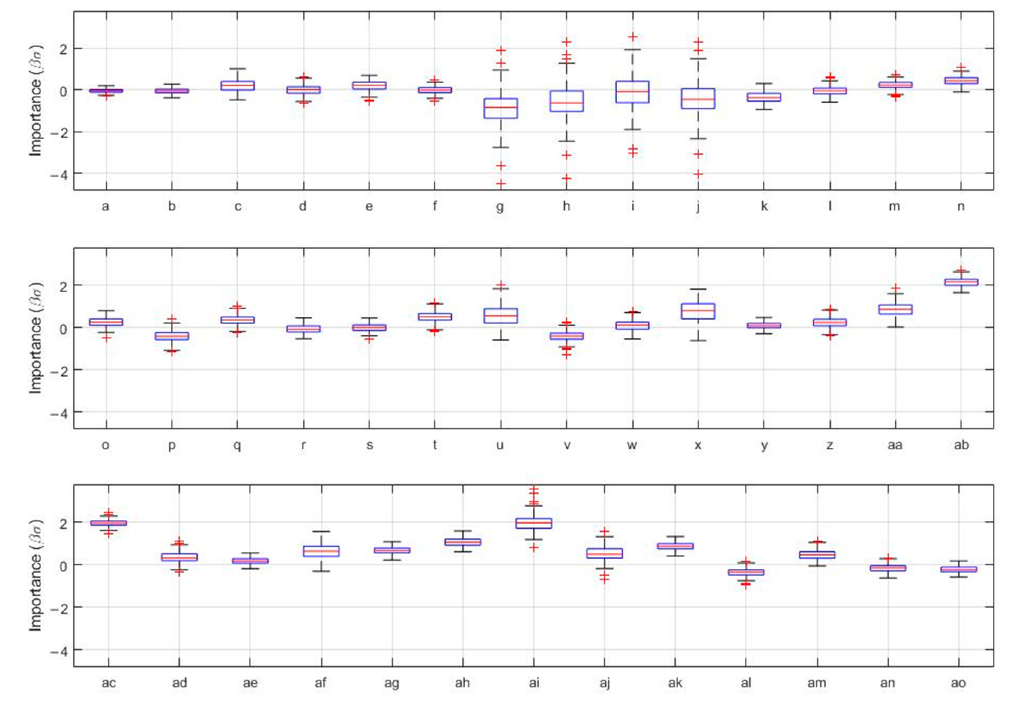
Figure 2. Machine learning models of vaccine hesitancy; boxplots of out-of-sample importance of factors from a single imputation and 200 repetitions of bootstrap resampling for logistic regression models, with the outcome of significant or some hesitancy vs. no hesitancy. a Age; b sex (male); c role (family member); d role (health care professional), e role (patient); f part of a vulnerable population (yes); g highest level of education (bachelor’s degree or above); h highest level of education (high school graduate); i highest level of education (some high school); j highest level of education (technical/vocational training); k employment (retired), l employment (yes); m living with (healthy adults); n living with (high risk people); o living with (susceptible people); p immunosuppression (yes—other); q immunosuppression (yes—rheumatic disease); r cancer (yes); s hypertension (yes); t diabetes mellitus (yes); u kidney disease (yes); v smoke (yes); w previous influenza vaccine (yes); x previous COVID-19 infection (yes); y language (English); z previously rejected influenza vaccine (yes); aa perception of receiving enough information about COVID-19 prevention (no); ab vaccine compulsory (no); ac vaccine compulsory (unsure), ad trust that the government is making decisions in citizens’ best interest regarding COVID-19 vaccines (no); ae access barrier to vaccination would prevent participants from receiving a COVID-19 vaccine (yes); af trust pharmaceutical companies to provide safe and effective COVID-19 vaccines (no); ag trust pharmaceutical companies to provide safe and effective COVID-19 vaccines (unsure); ah concerns that a future COVID-19 vaccine might not be safe (a little concerned); ai concerns that a future COVID-19 vaccine might not be safe (very concerned); aj vaccine benefits outweigh its risks (no); ak vaccine benefits outweigh its risks (unsure); al social pressure to receive a COVID-19 vaccine in the future (no); am social pressure to receive a COVID-19 vaccine in the future (unsure); an risk-taking behavior (moderate); ao risk-taking behavior (high).